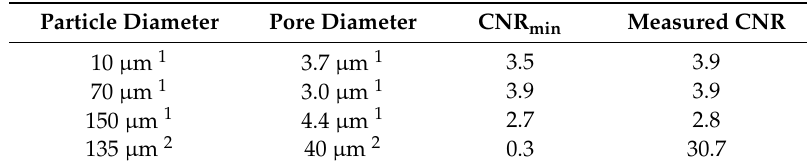
Table 2. Detectable pore size diameters for different particle sizes (at a maximum gray value of GV max = 4200).